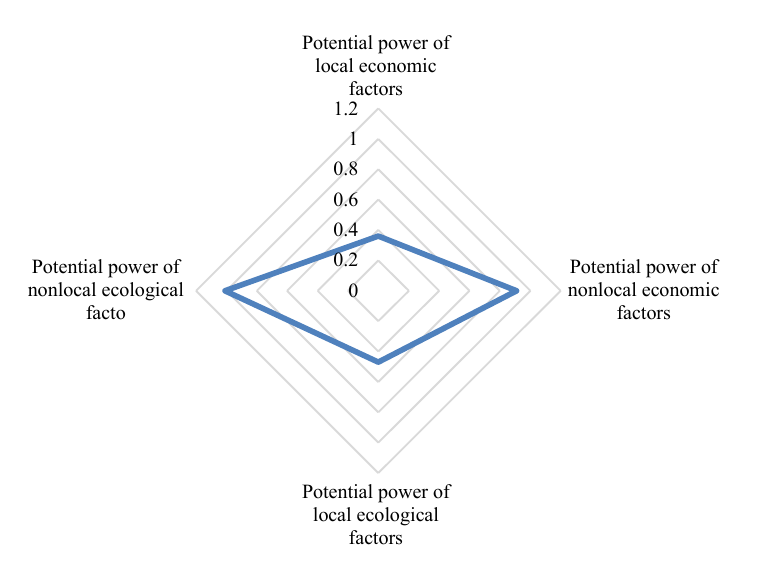
Fig. 3. Diagram of private potentials’ indicators influence for the standard